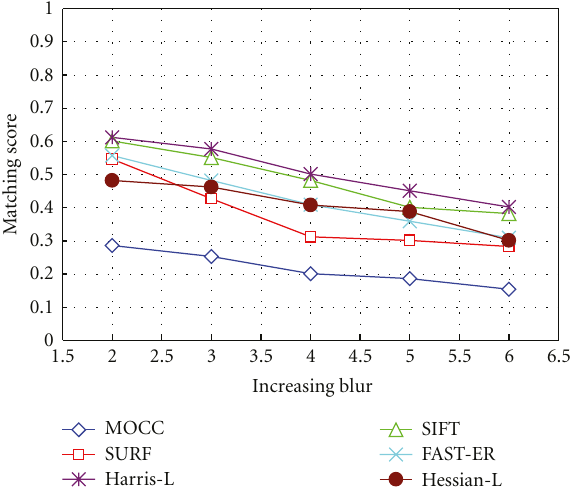
Figure 19: Matching results on images with blurring (Bikes